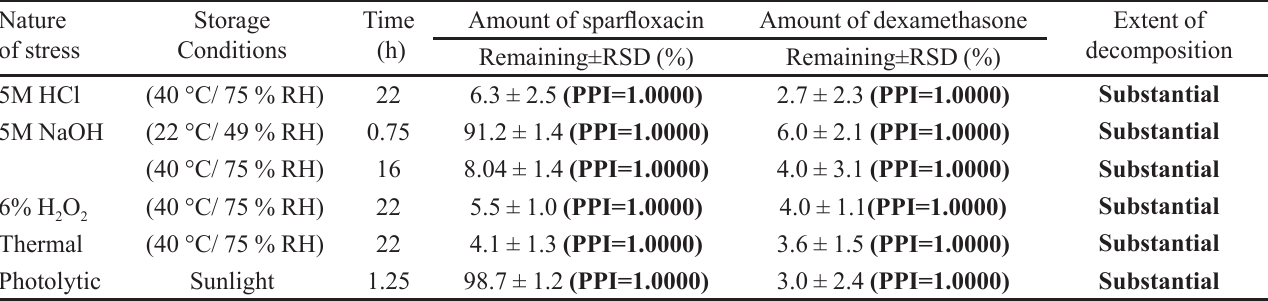
TABLE V - Stress Testing Results of sparfloxacin and dexamethasone Nature